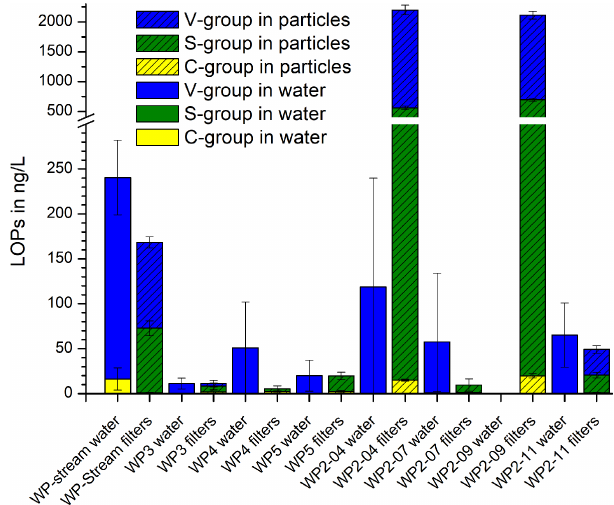
Figure 7. LOP concentrations of the filtered dripwater samples from Waipuna Cave and of the particulate matter retained in the